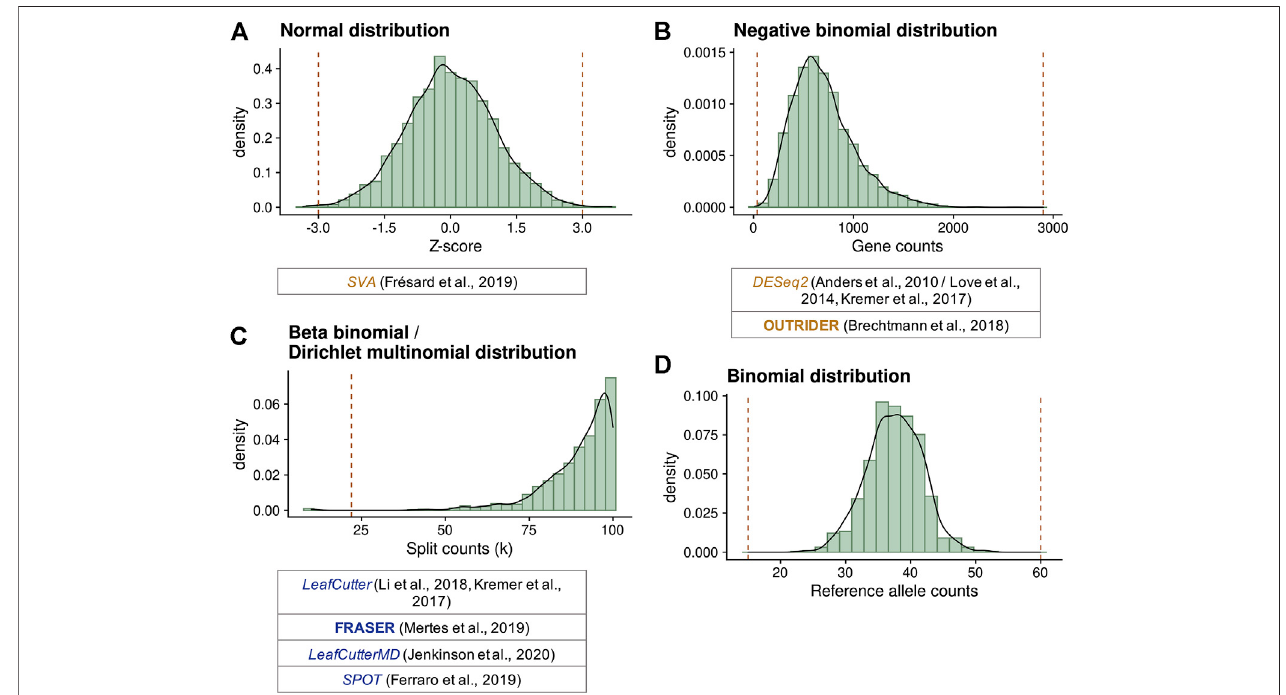
FIGURE3| Statisticaldistributionsusedtomodelgeneexpressiondataandcomputeoutliers. (A) Standardnormaldistributionsimulatingstandardizedresidualor Z-scores.Here,cutoffsde fi ningoutliersat ± 3(verticallines)wereselected. (B) Negativebinomialdistributionsimulatinggenecountswithameanof700anddispersionof 5. Values lower than 36 or greater than 2,899 (vertical lines) have a probability lower than 10 − 5 to occur, re fl ecting expression outliers. (C) Beta-binomial distribution simulating the distribution of split counts (n (D, A)) given a total of 100, with a ψ expectation of 0.9 and a correlation of0.1. Values lower than 22 (vertical line) have a probability lower than 10 − 5 to occur, re fl ecting splicing outliers. Dirichlet-multinomial distributions are multidimensional extensions of beta-binomial distributions. (D) Binomialdistributionsimulatingthecountsofeachalleleonaselectedvariantwithatotalof75countsandaprobabilityof0.5.Biological-relevantcutoffsat20and80%of allelic ratio (15 and 60 counts) indicate MAE. Extensions ofthis distribution have been proposed toaccountfor the genetic variation byANEVA-DOT and the MAE test of Kremer et al. (2017). Below each diagram, different methods using these distributions are